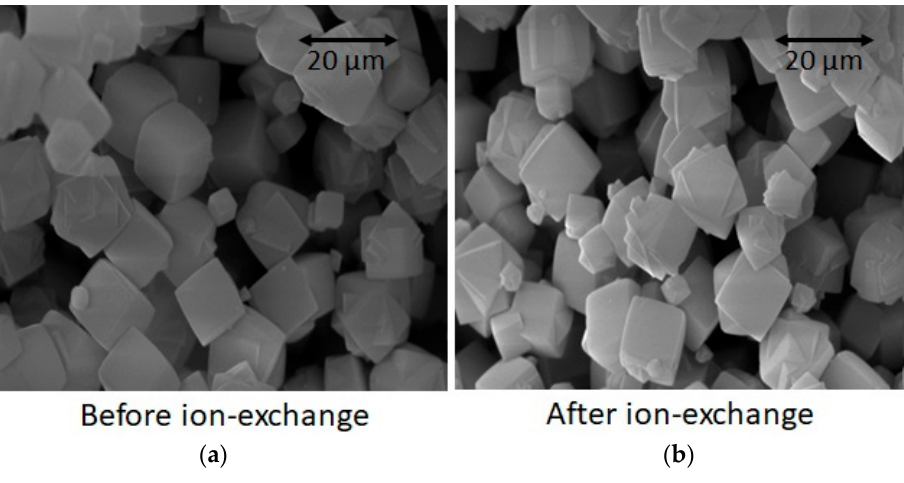
Figure 2. SEM images of ( a ) 4A zeolite and ( b ) Ag-Zn form A zeolite.